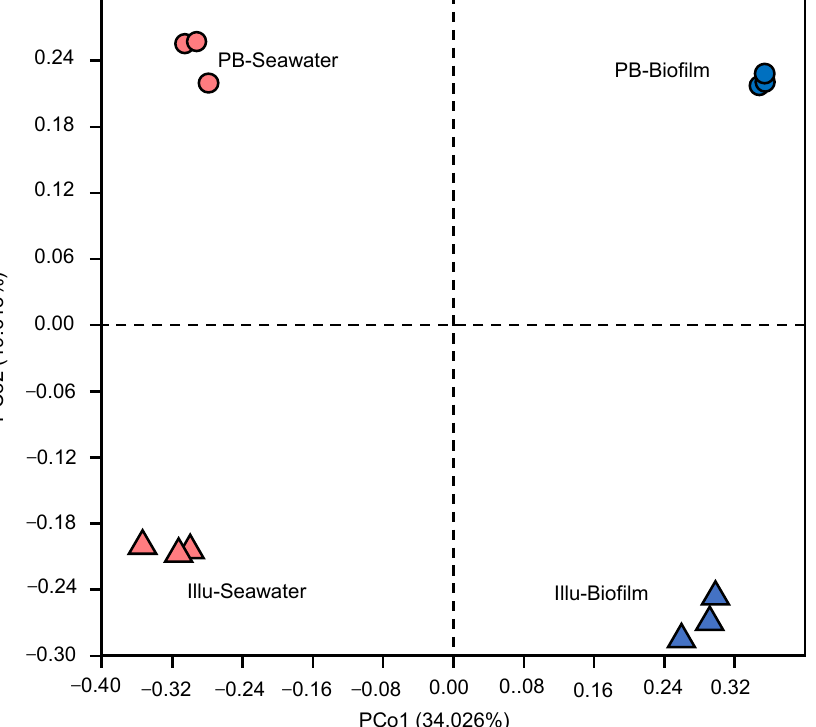
Figure 1. Rarefaction curves showing sequence number and α -diversity correlations. The three biofilm and three seawater samples are indicated by different colors. Chao1 richness and Shannon (H index) diversity were calculated based on the PacBio ( A ) and the Illumina datasets ( B ). For each sample, 100,000 sequences were included for analysis, and the average value of 10 permutations is shown.